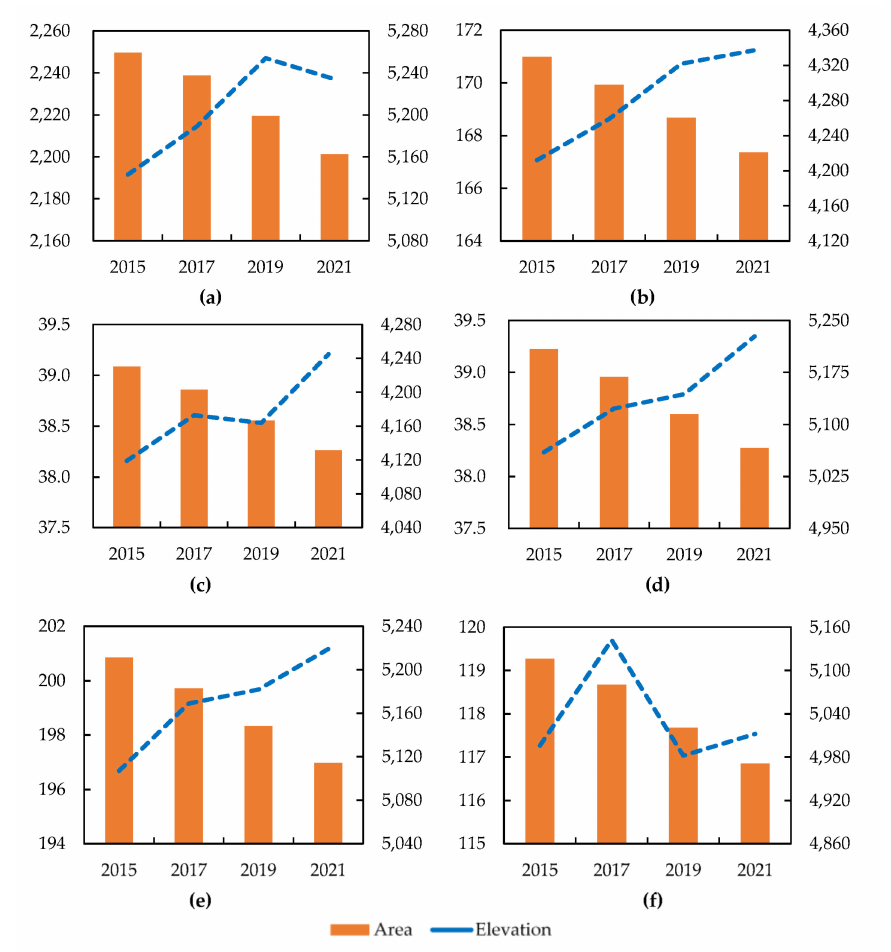
Figure 11. The glacier area and elevation distribution. ( a ) Golmud City; ( b ) Yushu City; ( c ) Chengduo County; ( d ) Qumalai County; ( e ) Zaduo County; ( f ) Zhiduo